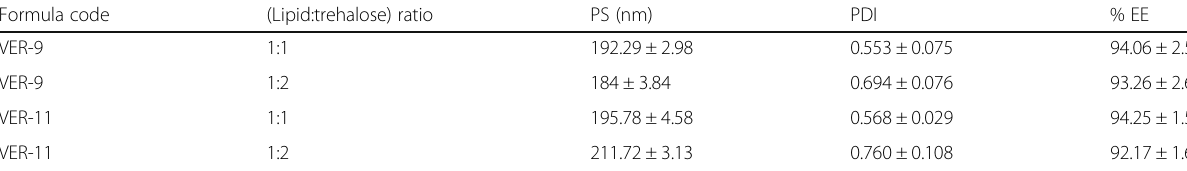
Table 5 Addition of trehalose during homogenization (after lyophilization) Formula code